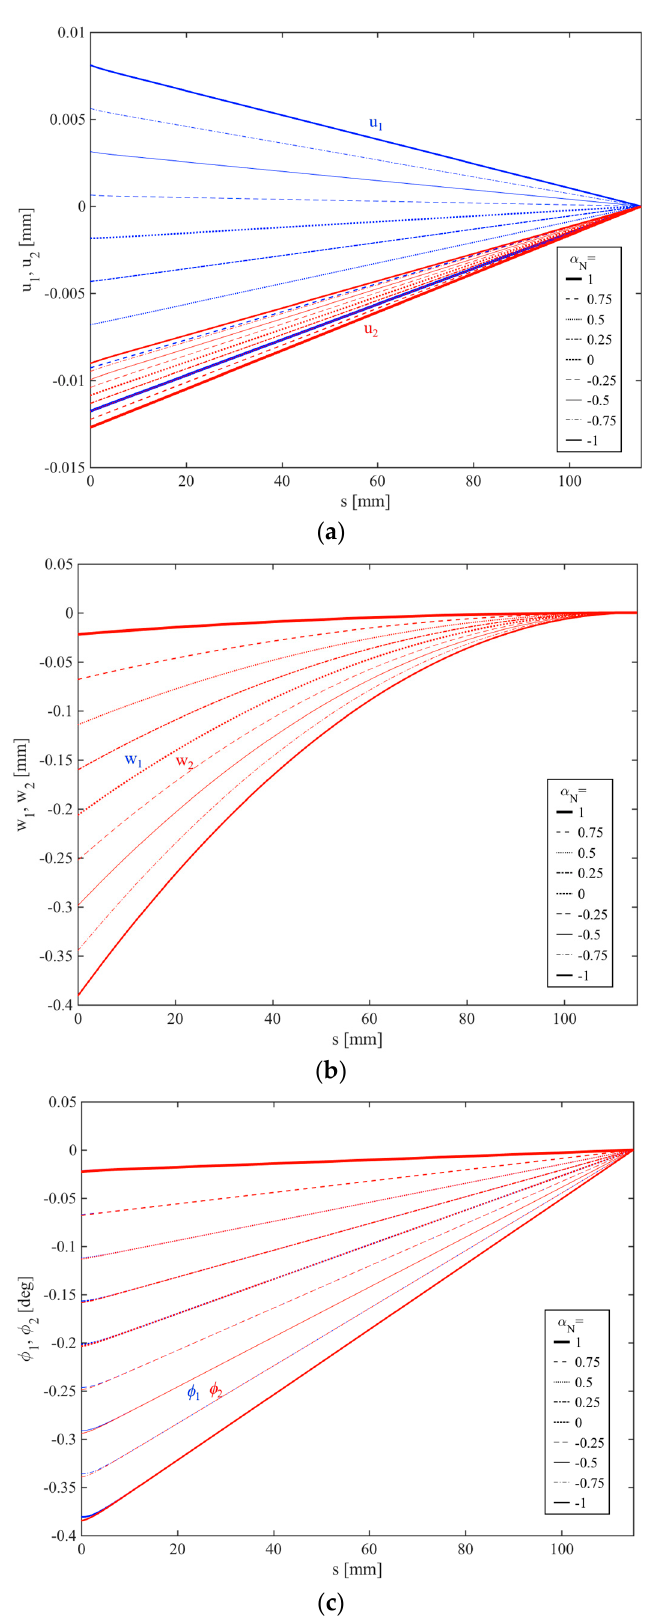
Figure 10. Effect of the axial loading on the kinematic response of the sublaminates: ( a ) Axial displacement; ( b ) Shear displacement; ( c ) Cross-sectional rotation. (Orthotropic specimen).